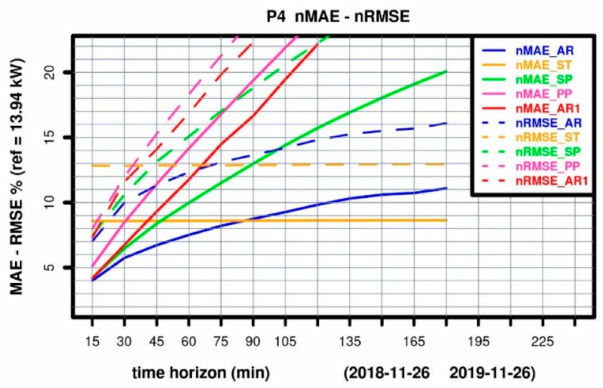
Figure 9. nMAE (solid) and nRMSE (dashed) errors as a function of the prediction horizon for ARIMAX (AR) in blue, optimized short-term forecasting (ST) in orange, smart persistence (SP) in green, pure persistence (PP) in pink and ARIMAX without ST as input (AR1) in red, related to the plants P4.